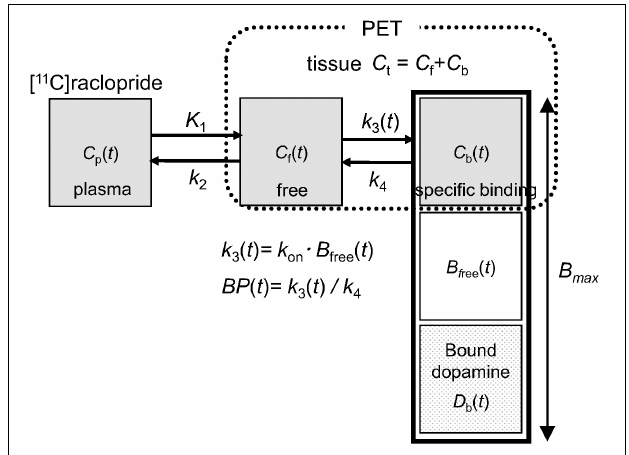
FIGURE 1 | Extended compartment model including competition between administered [ 11 C]raclopride and endogenous dopamine proposed in Endres et al. (21). Total receptor density ( B max ) is the sum of the free receptors ( B free ) and receptors bound by raclopride ( C b ) and dopamine ( D b ). A model parameter k 3 ( t ), representing the rate constant from the free compartment ( C f ) to the specific binding compartment ( C b ), depends on the association rate constant of [ 11 C]raclopride ( k on ) and density of available receptors ( B free